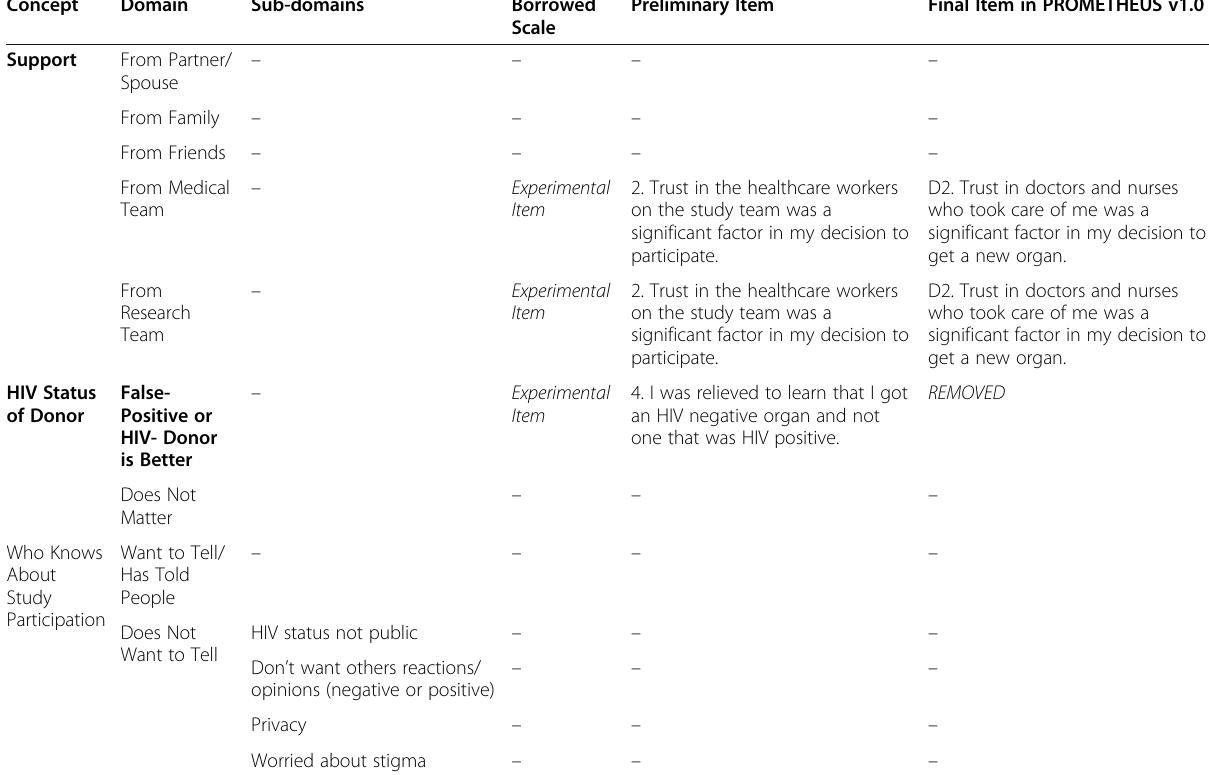
Table 2 PROMETHEUS concepts and domains with items